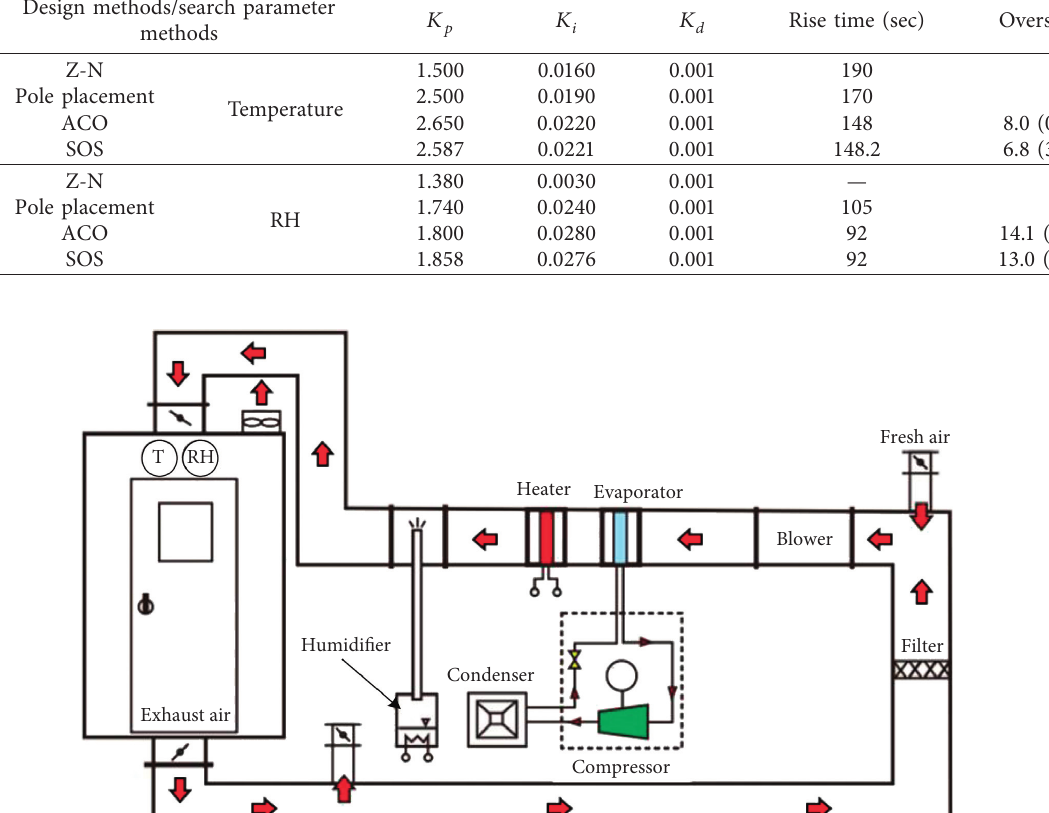
Figure 7: Schematic diagram of a comfortable room.